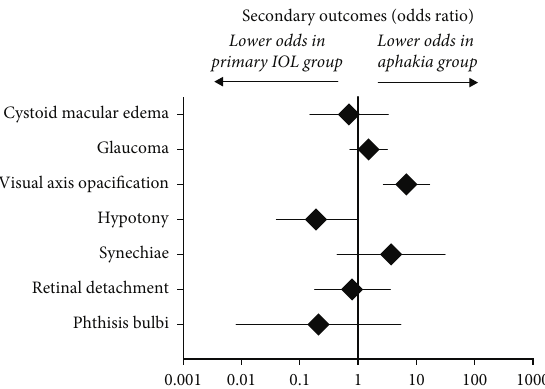
Figure 4: Overview of the secondary outcome meta-analyses. Summary estimates are odds ratio (OR). Significant differences between groups were visual axis opacification (OR 6.76, 95% CI: 2.73 to 16.8, P � 0 . 000037, i.e., more likely in those with primary IOL implantation group/less likely in aphakia) and hypotony (OR 0.19, 95% CI: 0.04 to 0.95, P � 0 . 044, i.e., less likely in those with primary IOL implantation group/more likely in